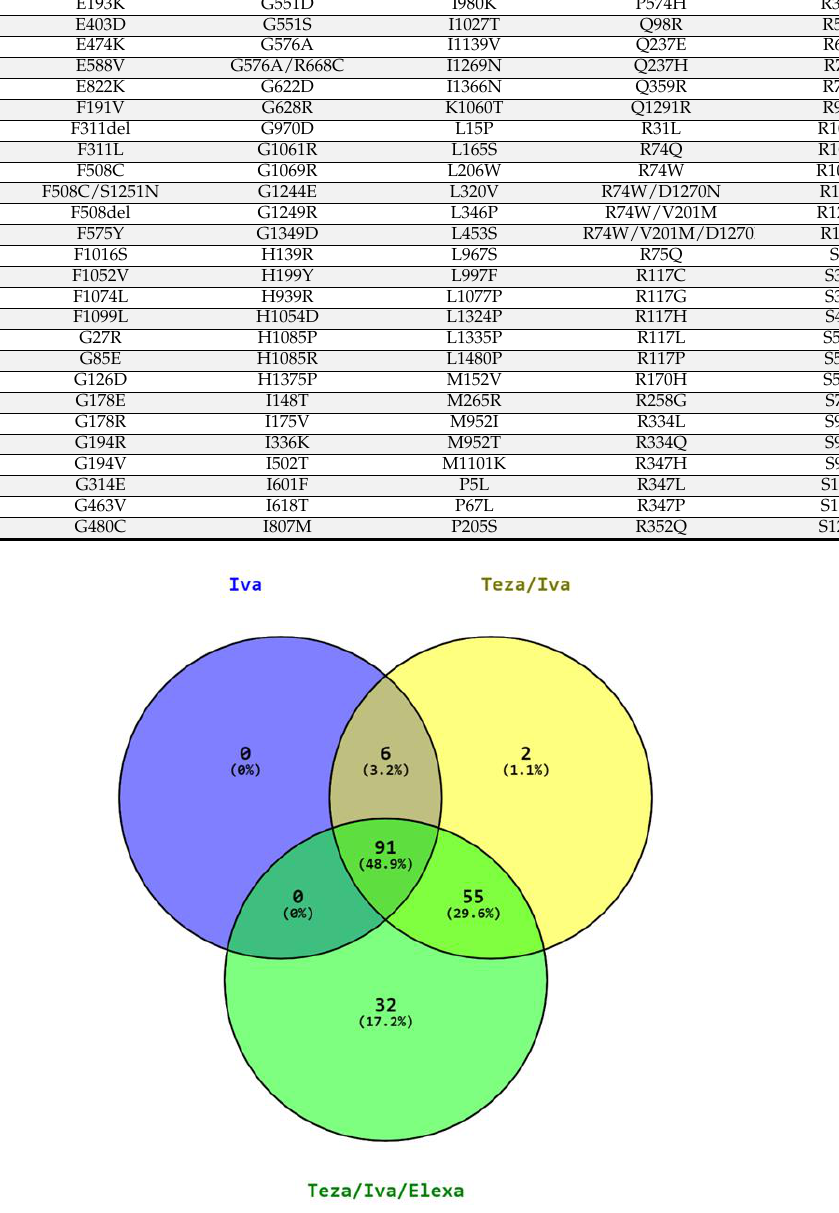
Figure 1. Venn Diagram showing the number and relative percentage of mutations identified so far as responsive to Ivacaftor (Iva) or to the combinations of the correctors Tezacaftor (Teza) and Elexacaftor (Elexa) with the potentiator (Iva).